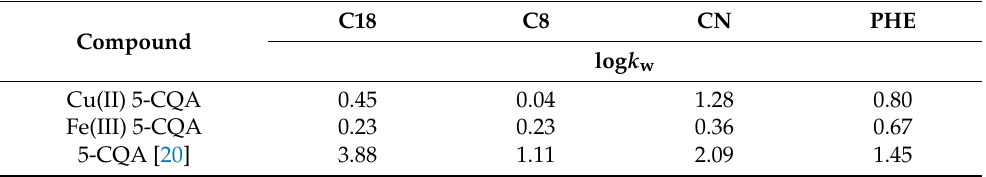
Table 3. Lipophilicity parameters determined by chromatographic methods (the logarithm of the retention factor, log k w ) for the Cu(II) and Fe(III) chlorogenates and chlorogenic acid [20].